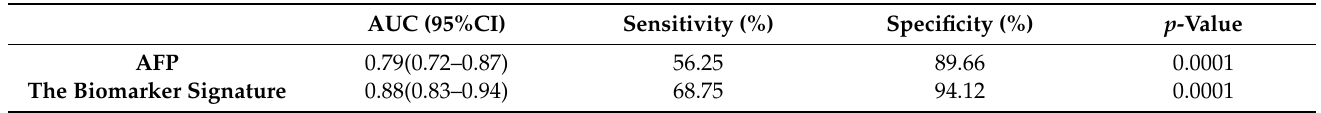
Figure 6. The specificity of the biomarker signature in the diagnosis of T2DM(+) HCC patients. ( A ) The ROC curve of the biomarker signature for discriminating T2DM(+) HCC from T2DM(+) CRC&PC&GC patients. ( B ) The ROC curve of AFP for discriminating T2DM(+) HCC from T2DM(+) CRC&PC&GC patients. T2DM, type 2 diabetes mellitus; HCC, hepatocellular cancer; CRC, colorectal cancer; PC, pancreatic cancer; GC, gastric cancer; ROC, receiver operating characteristic; AUC, area under the ROC curve. Table 6. The diagnostic specificity of the biomarker signature for the detection of T2DM(+) HCC from T2DM(+) CRC&PC&GC.